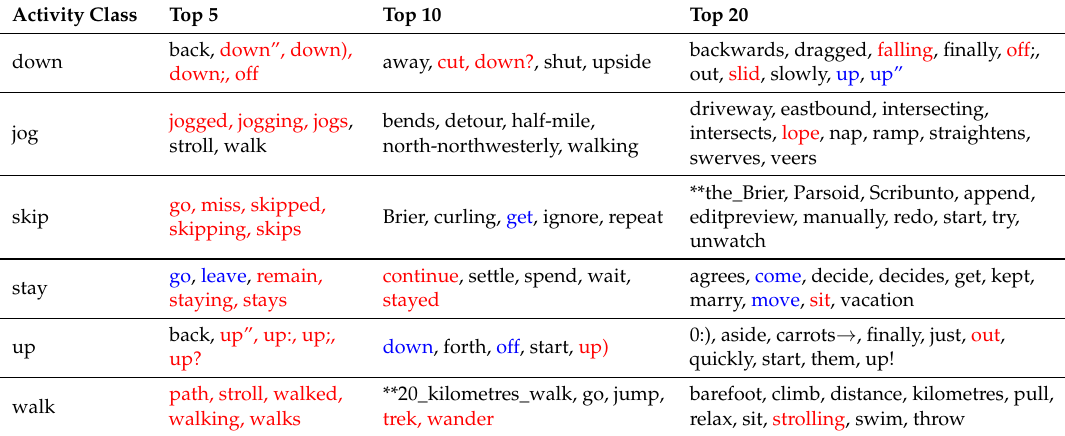
Table A4. Top 20 most similar words for each activity class in the HASC dataset. The symbol ** indicates that “DBPEDIA_ID/” has been omitted. The color of red represent synonyms and blue for antonyms.